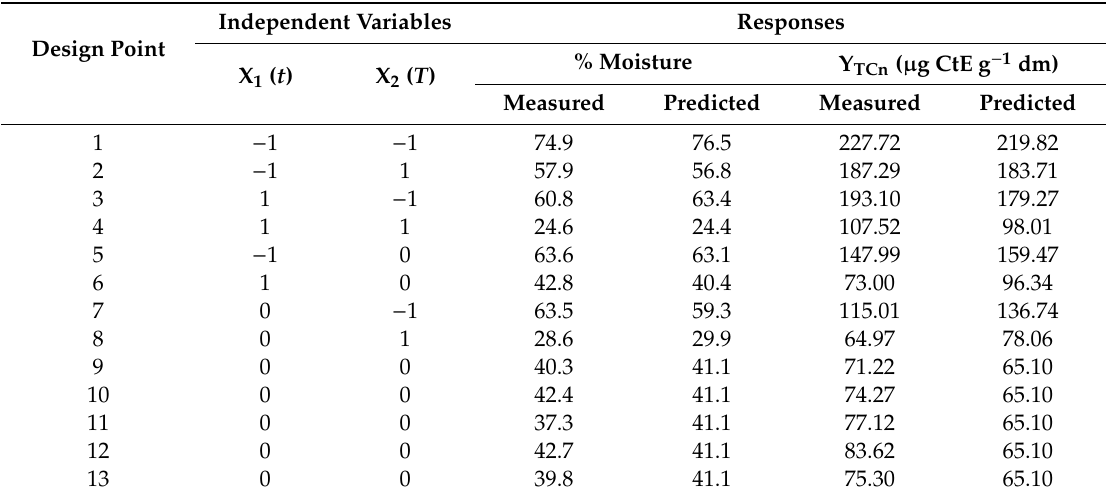
Table 2. Measured and predicted responses for all design points considered for the experimental design. Design Point